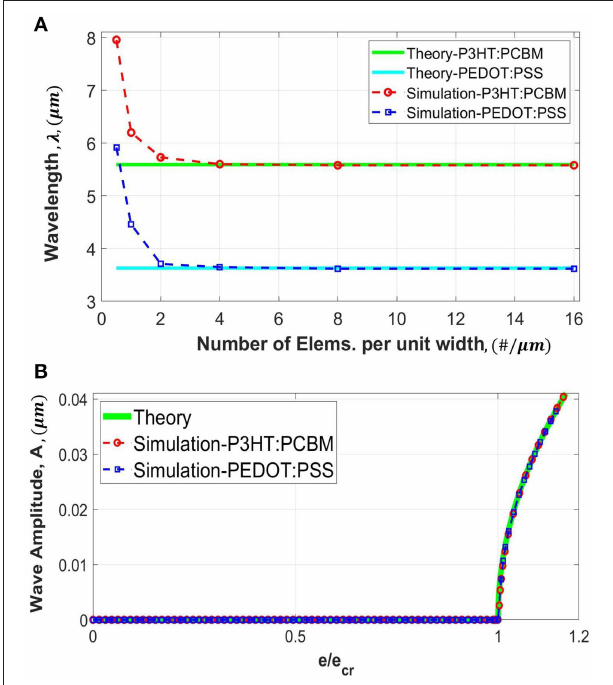
FIGURE 3 | Convergence study for a single-layer film-substrate system, using continuum eight-noded quad elements, for the cases of generalized plane strain under direct compression. Results from two different film materials of P3HT:PCBM and PEDOT:PSS are included. (A) Variation of the simulated wrinkling wavelength with the number of elements per unit width. (B) Variation of the simulated wrinkling amplitude with applied strain normalized by the ). Theoretical values are also included for comparison. critical strain ( e e cr